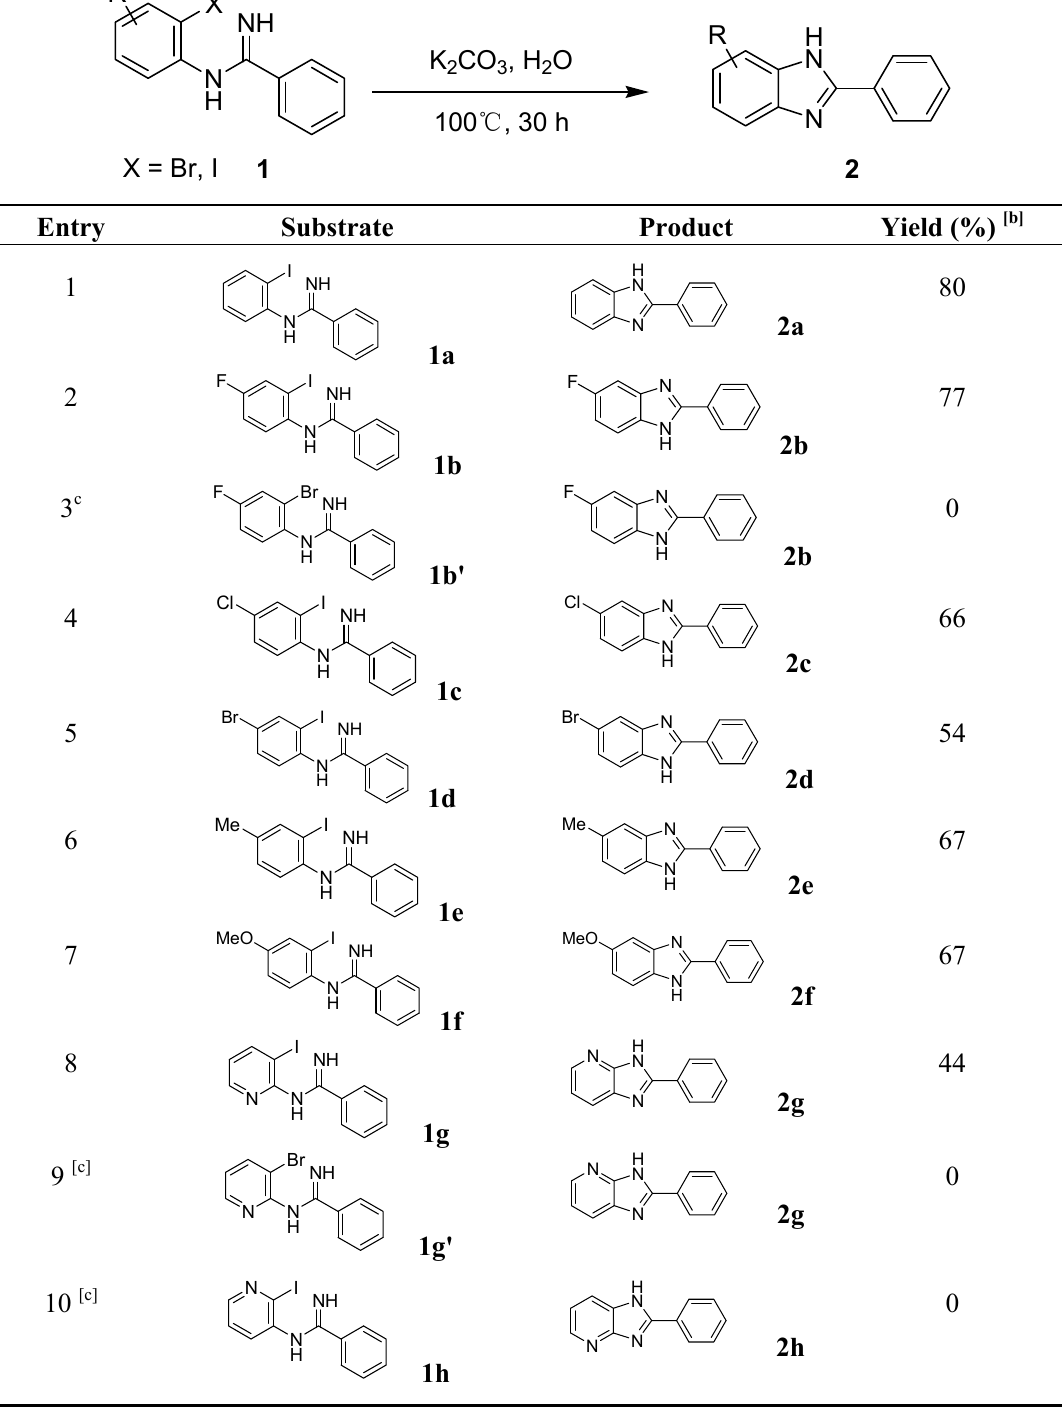
Table 2. Direct weak base-mediated synthesis of 2-phenylbenzimidazole derivatives in water [a]